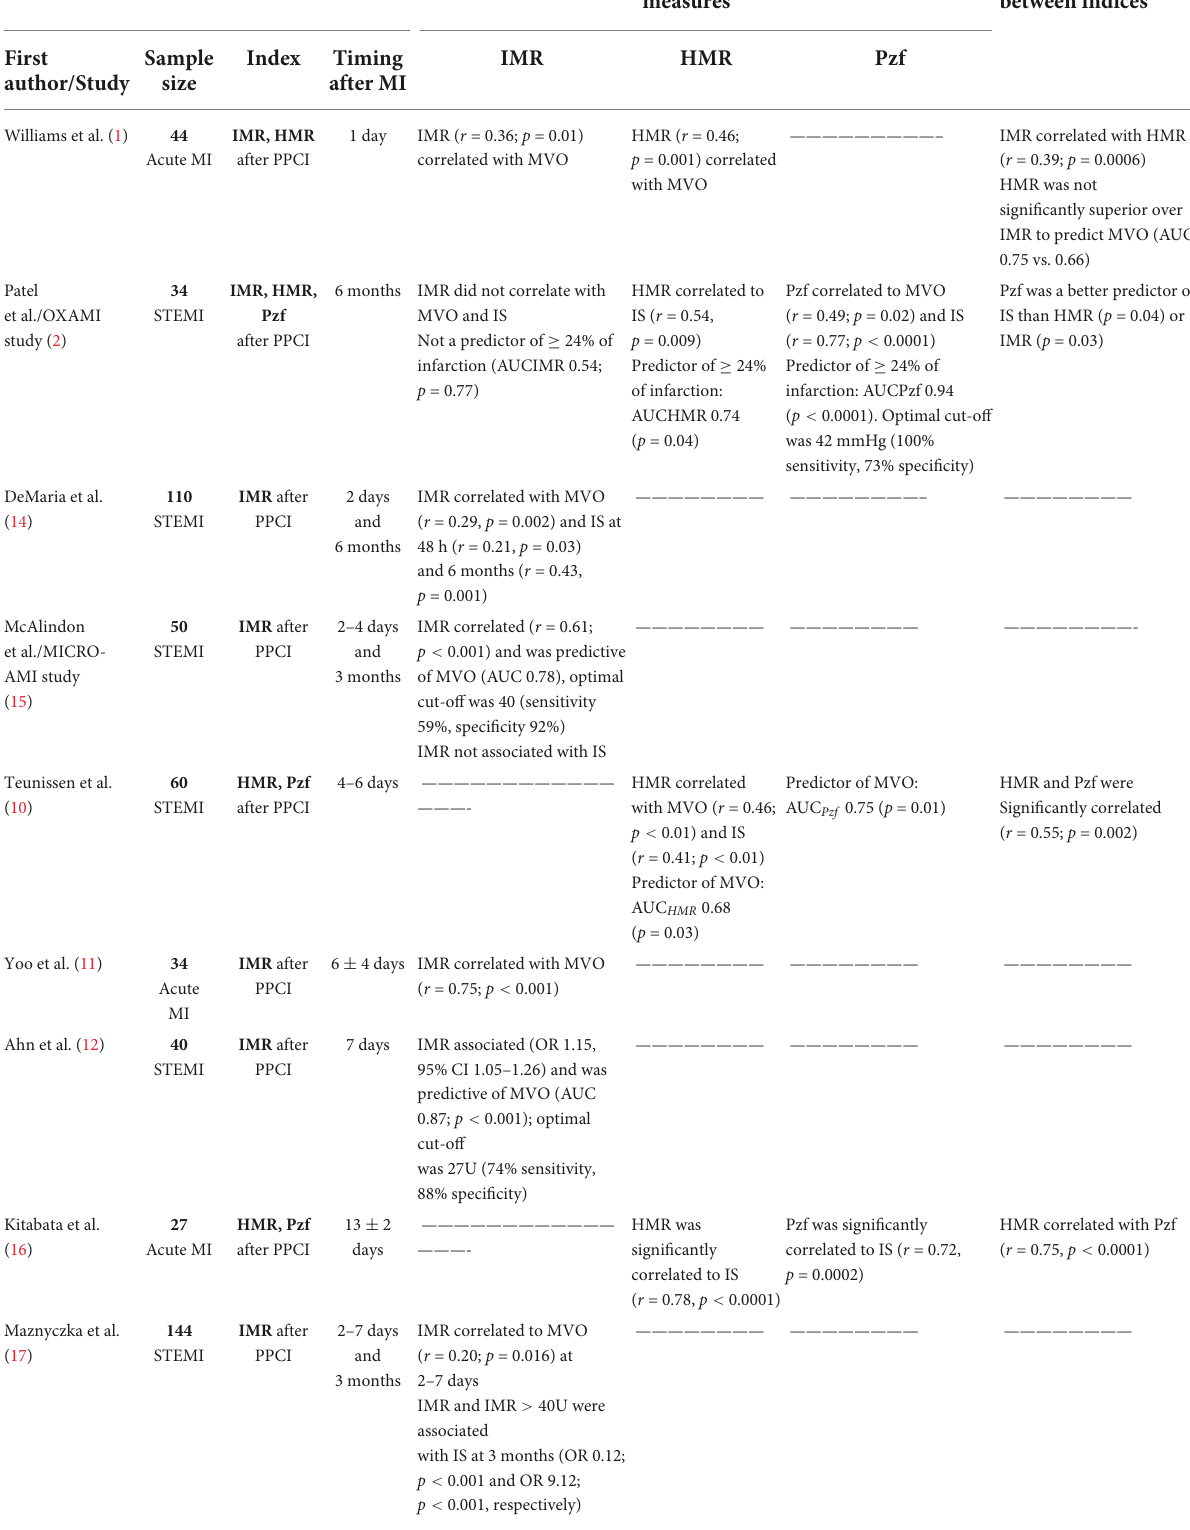
TABLE 1 Non-randomized controlled trials of microvascular resistance indices in acute MI associated with MVO and IS on CMR. CMR Cardiac imaging associations with microcirculation